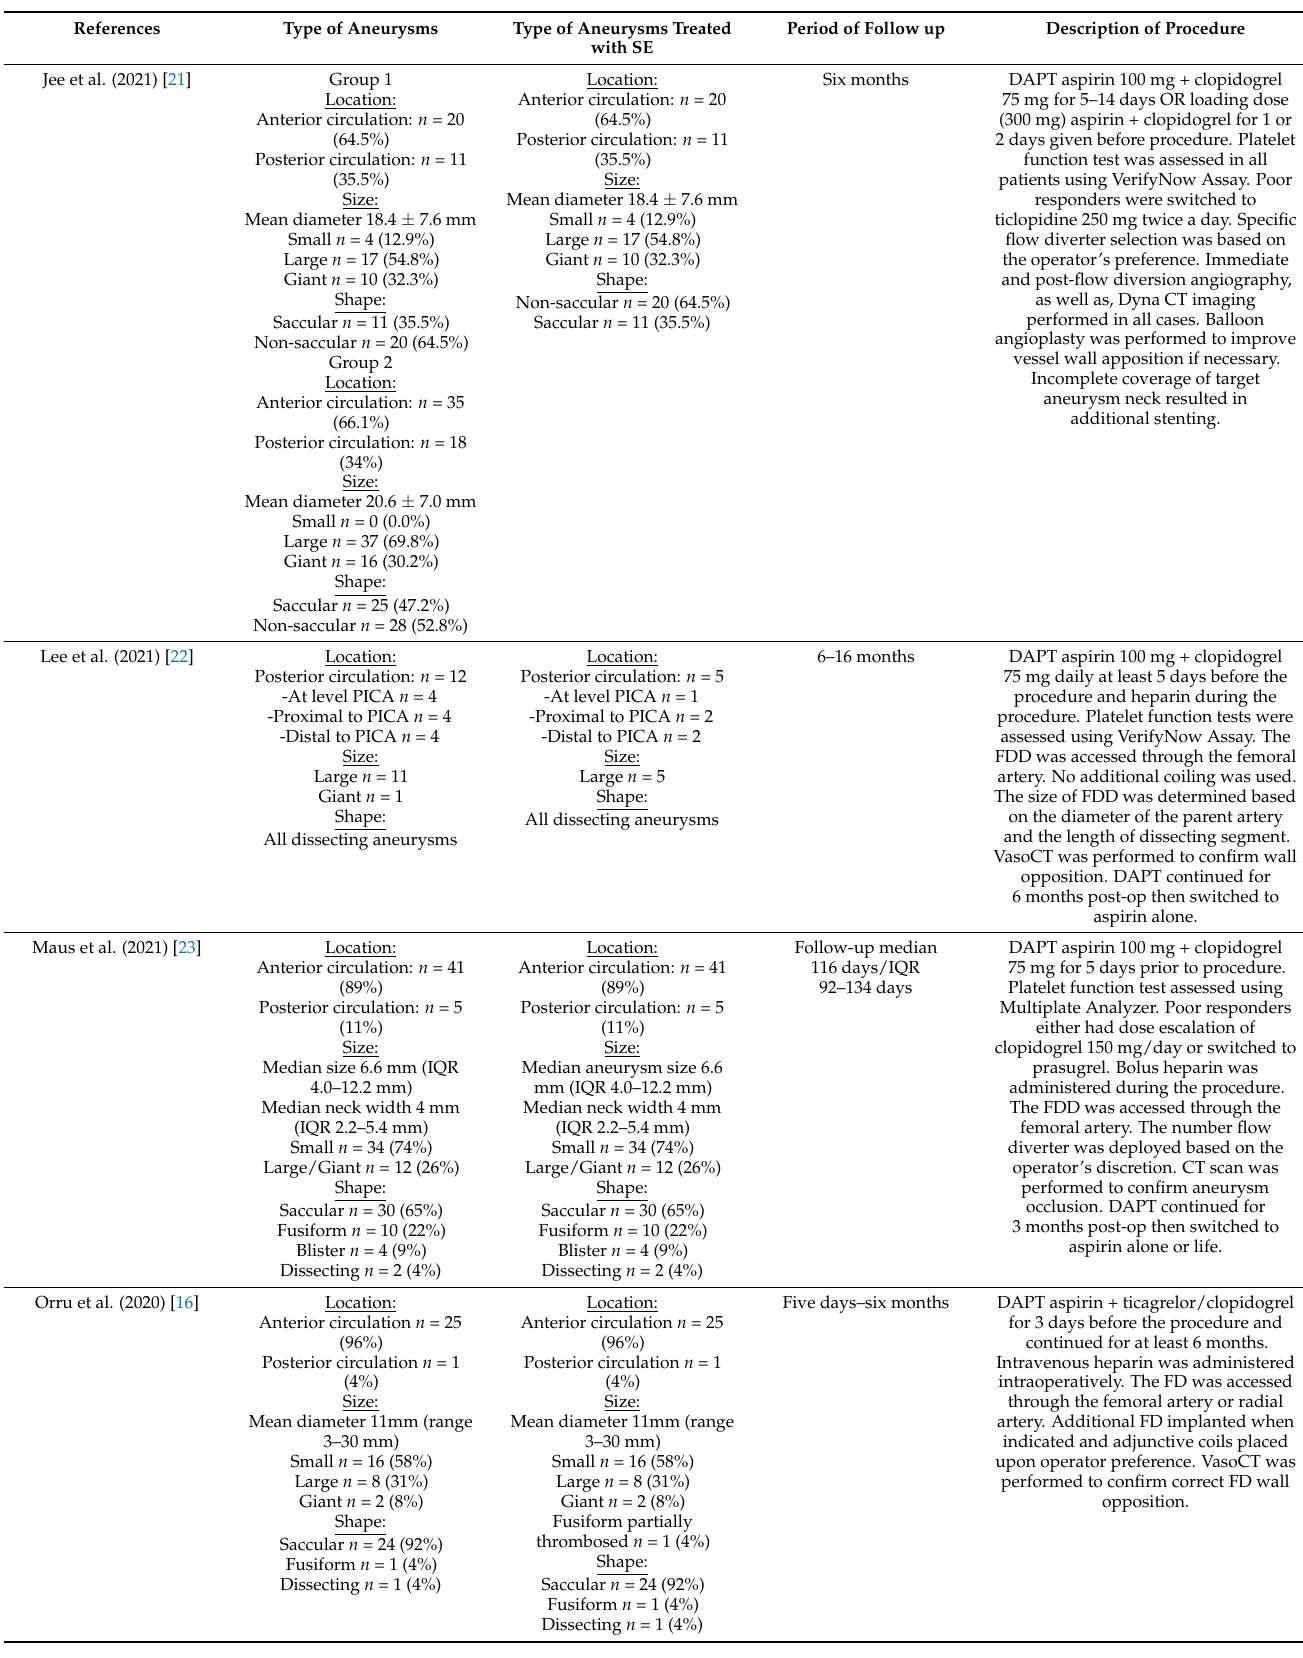
Table 4. Included studies type of aneurysms, period of follow-up, and description of the